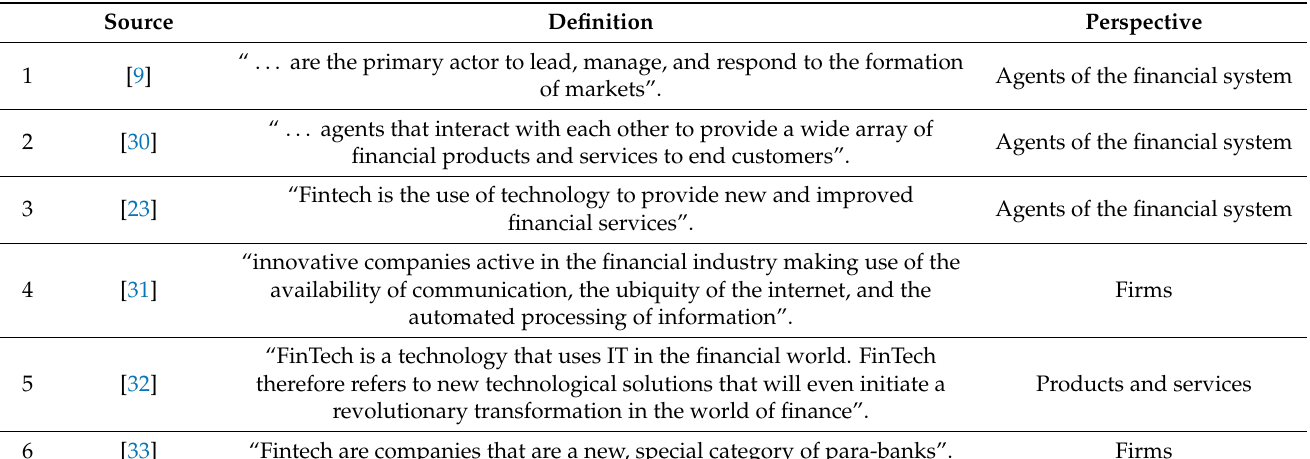
Table 1. Definitions for the term